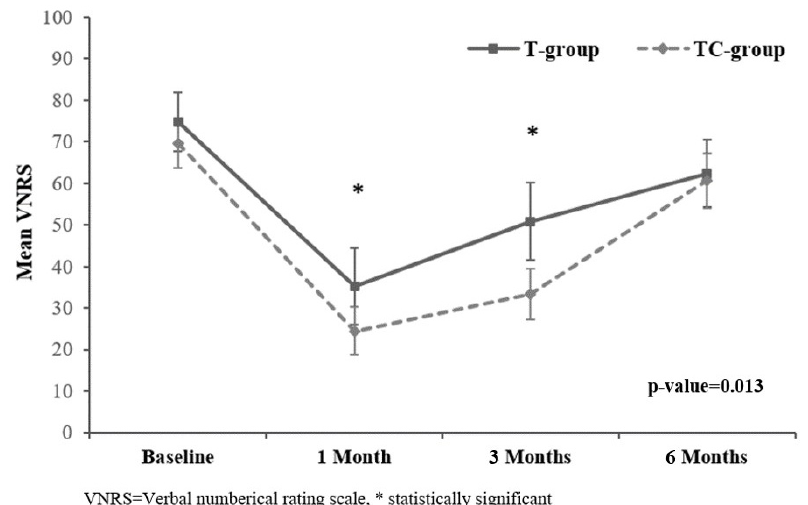
Figure 4. Average verbal numerical rating scale: between-group comparison (Line graph is presented with mean and 95%CI error bars) T group = transforaminal, TC group = transforaminal and